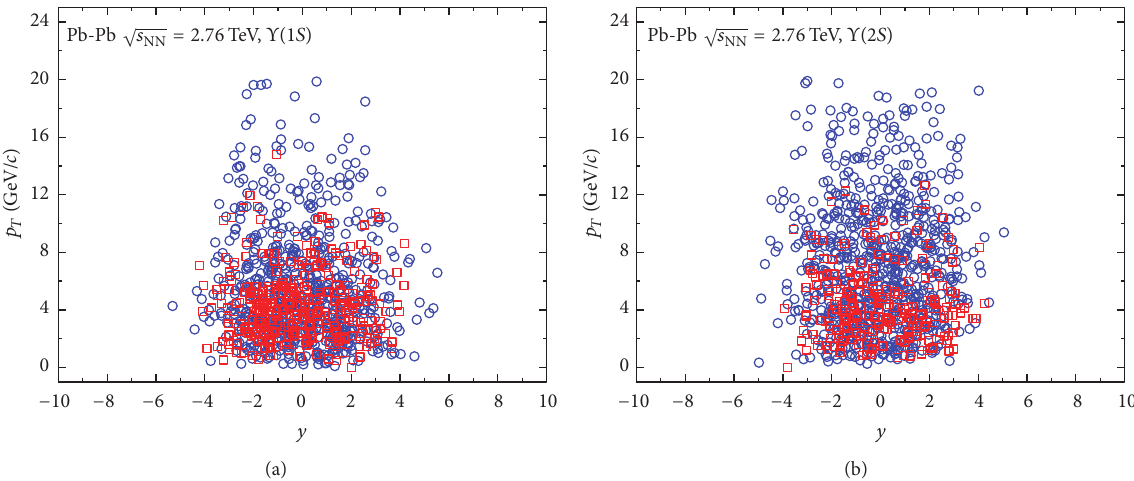
Figure 12: Same as Figure 3, but showing the results for (a) Υ(1𝑆) and (b) Υ(2𝑆) mesons produced in Pb-Pb collisions at √𝑠 NN = 2.76 TeV.